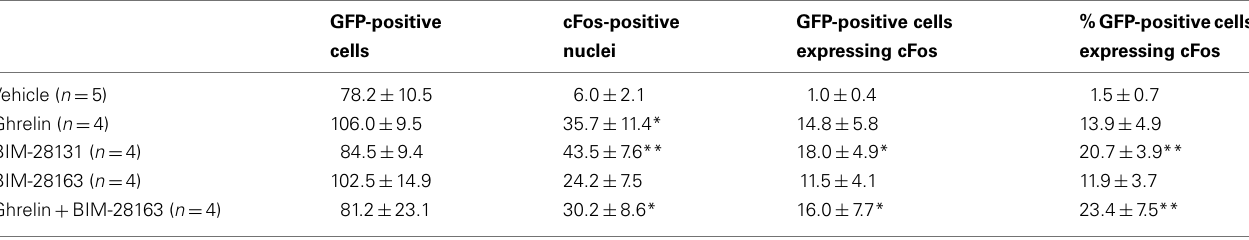
Table 2 | Effect of native ghrelin and BIM compounds on the number of GFP-positive cells, number of cFos-positive nuclei, number, and percentage of GFP-positive cells expressing cFos protein in theArcN in NPY-Renilla GFP mice.